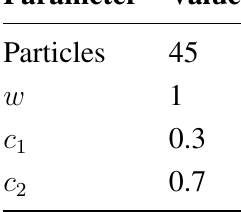
Table 1. Parameters used in PSO and BSO.